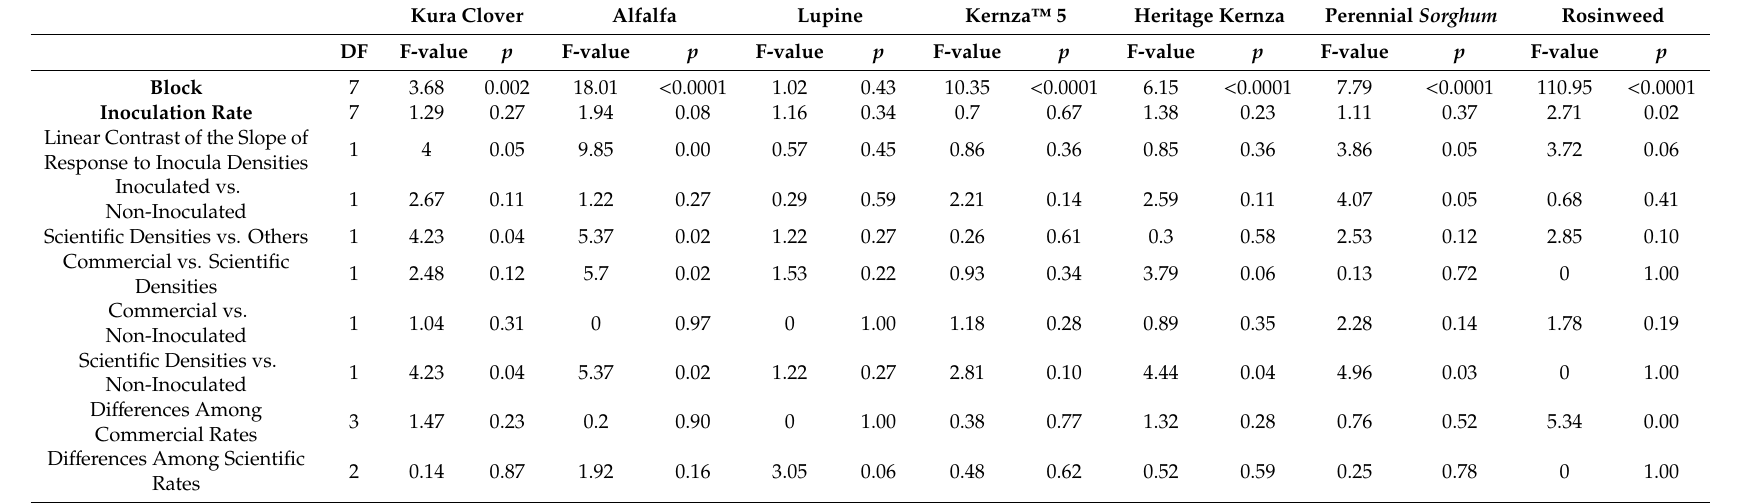
Table 2. Plant survival in the field (number of surviving seedling individuals per plot of each species) was strongly dependent on plot block and for some plant species, also on inoculation density. Because some inoculation densities were predicted to be too low to result in e ff ects on plant growth, we used contrasts within the inoculation term to test whether each plant di ff ered in growth response to di ff erent densities of mycorrhizal inoculation, including across and within the categories of having no inocula amendment, adding the low densities recommended by commercial producers of inocula, or adding the high density of mycorrhizal inocula often reported in the scientific literature. A linear contrast was also designed to test if plant response to inoculation was increasing predictably with inoculation